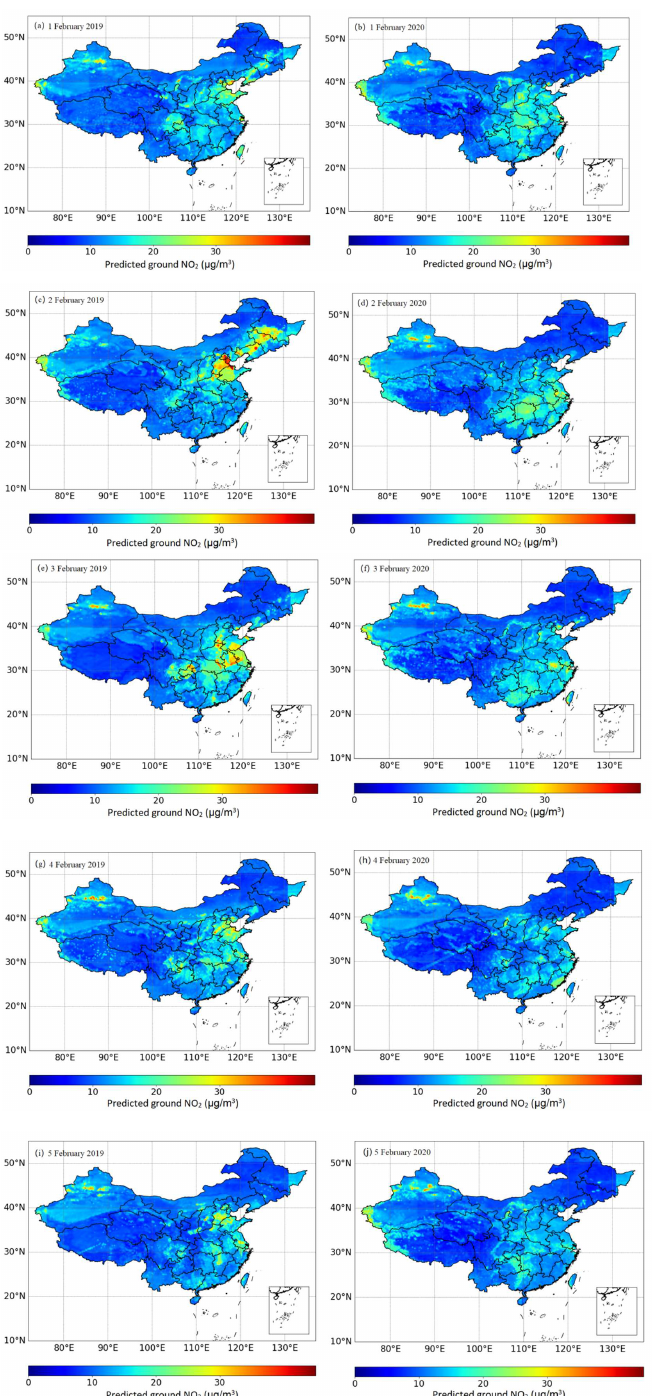
Figure 8. Estimated near-surface NO 2 concentrations by the RF model in China from 1 to 5 Febru- ary 2019 and 2020: ( a ) 1 February 2019; ( b ) 1 February 2020; ( c ) 2 February 2019; ( d ) 2